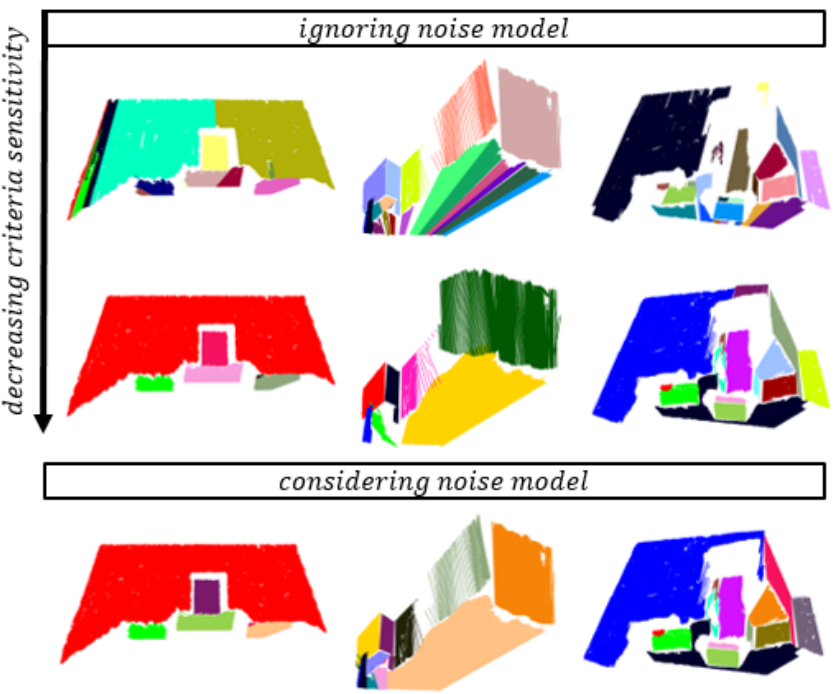
Figure 24. EPCC reduces over-segmentation by decreasing the sensitivity of clustering, which can inversely lead to increased sensitivity to the incorrect clustering, when disregarding the noise model in remote areas ( middle column ). This does not apply to nearby areas ( left and right